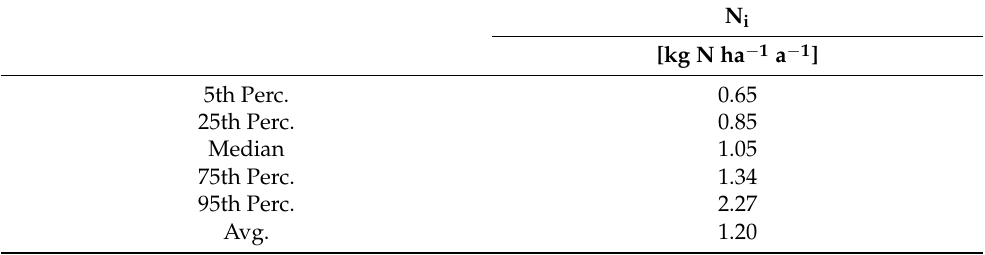
Table 15. Statistical distribution of the immobilization rates determined for the German receptor areas